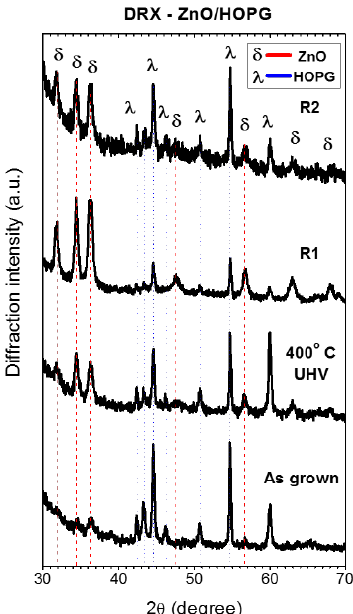
Figure 7. X-ray di ff raction patterns of as grown and thermal treated ZnO / HOPG samples. The samples Figure 7. X-ray diffraction patterns of as grown and thermal treated ZnO/HOPG samples. The samples details are given in the figure. Some HOPG (λ, 00-012-0212) and ZnO (δ, 01-075-1526) details are given in the figure. Some HOPG ( λ , 00-012-0212) and ZnO ( δ , 01-075-1526) di ff raction peaks diffraction peaks are also indicated. are also